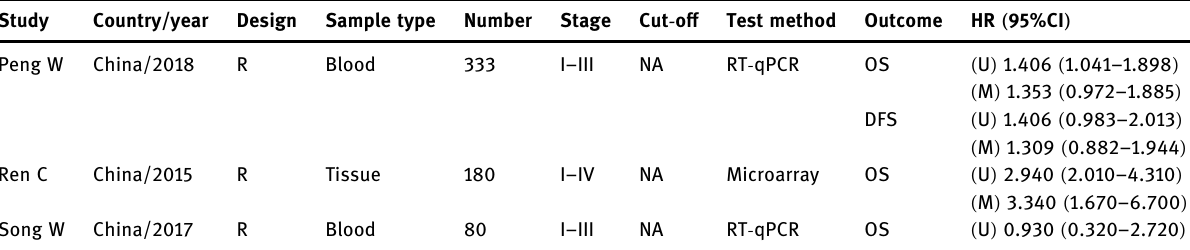
Table 2: Characteristics of the studies related to the prognosis of gastric cancer